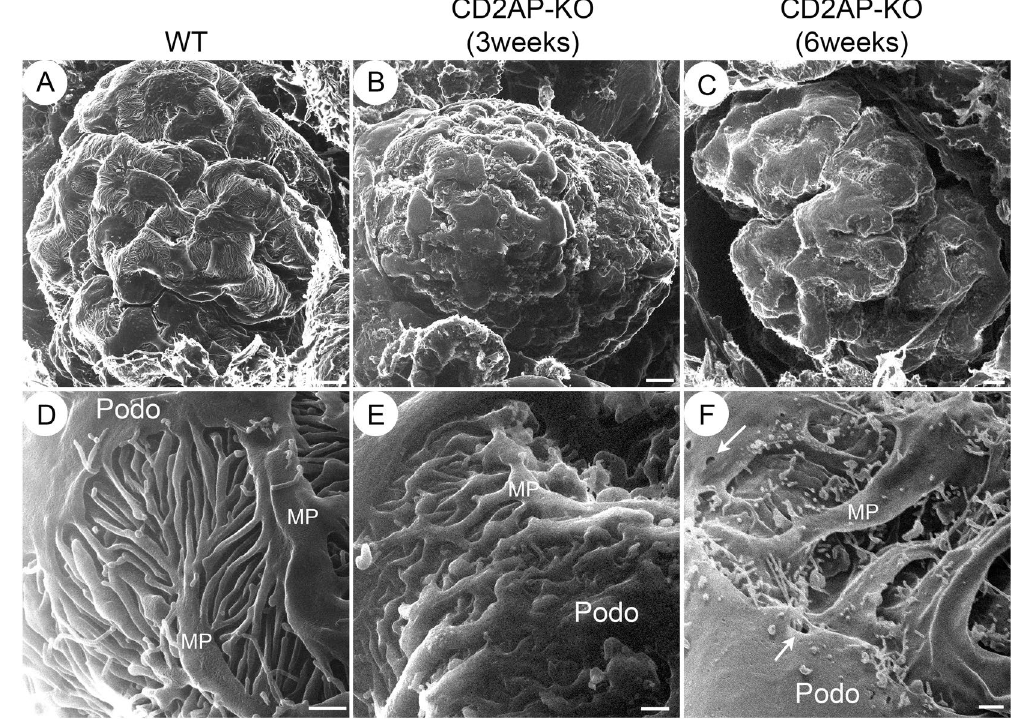
Figure 2. Glomerular and podocyte morphology in wild type (WT) and CD2AP deficient mice by HIM. HIM images of glomeruli in WT ( A , D ), 3 week-old Cd2ap -KO ( B , E ), and 6 week-old Cd2ap -KO mice ( C , F ). Low magnification image of a WT glomerulus ( A ) shows major processes and foot processes covering the glomerular capillaries, while images of 3 week-old Cd2ap- KO ( B ) and 6 week-old Cd2ap -KO kidneys ( C ) show a less regular and less smooth surface of podocytes. High magnification images of WT glomeruli ( D ) show a smooth podocyte cell body and well-organized interdigitating foot processes. A few filamentous microprojections originate from the podocyte cell body, major processes and foot processes. Conversely, the foot processes are swollen and appear short and severely flattened in the 3 week-old Cd2ap -KO kidney ( E ). Foot processes are fused and tend to disappear in 6 week-old Cd2ap -KO kidney ( F ). The primary processes are preserved, but appear “peeled away” from the underlying capillary loops. Numerous “bleb-shaped” short microprojections mixed with a few filamentous “cilia-like” structures project from the podocyte cell body. There are holes ranging from 100–400 nm in diameter on the surface of the podocyte cell body. Scale bars, 5 μ m in upper panels; 500 μ m in lower panels. Podo, podocyte; MP, major